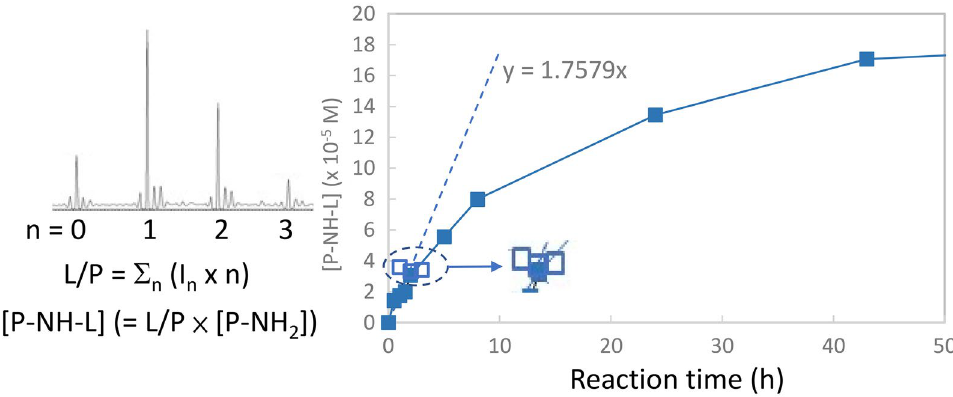
Figure 1. The initial rate ( v 0/ NH2 ) measurement based on the slope (dashed line) of the time course study of the reaction of Her-IgG (5.73 μM) with AD-PEG-N 3 (3 mM) (closed) and NHS-PEG-N 3 (50 mM) (open). The products (P–L) were monitored as L/P ratios or the converted [P-HL-L] using intact protein measurement